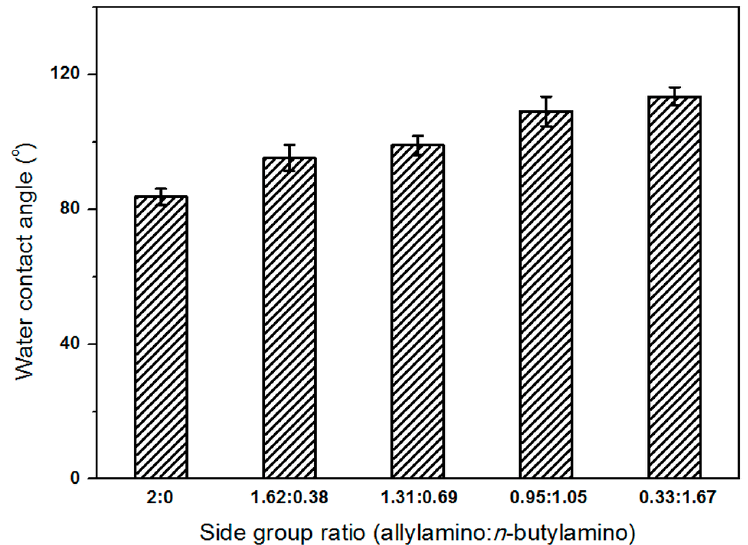
Figure 2. Effect of side group molar ratios on polymer hydrophilicity.